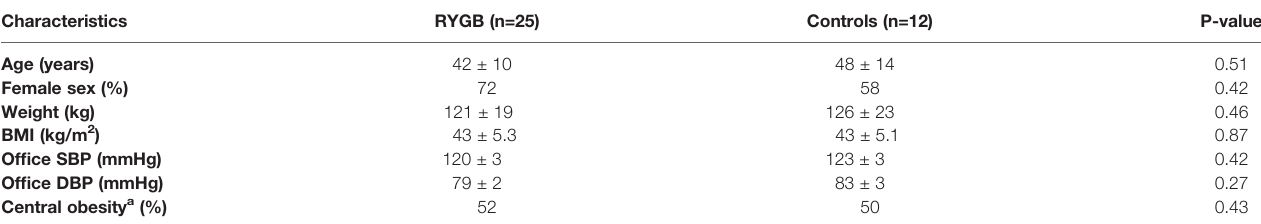
TABLE 1 | Baseline characteristics of the study